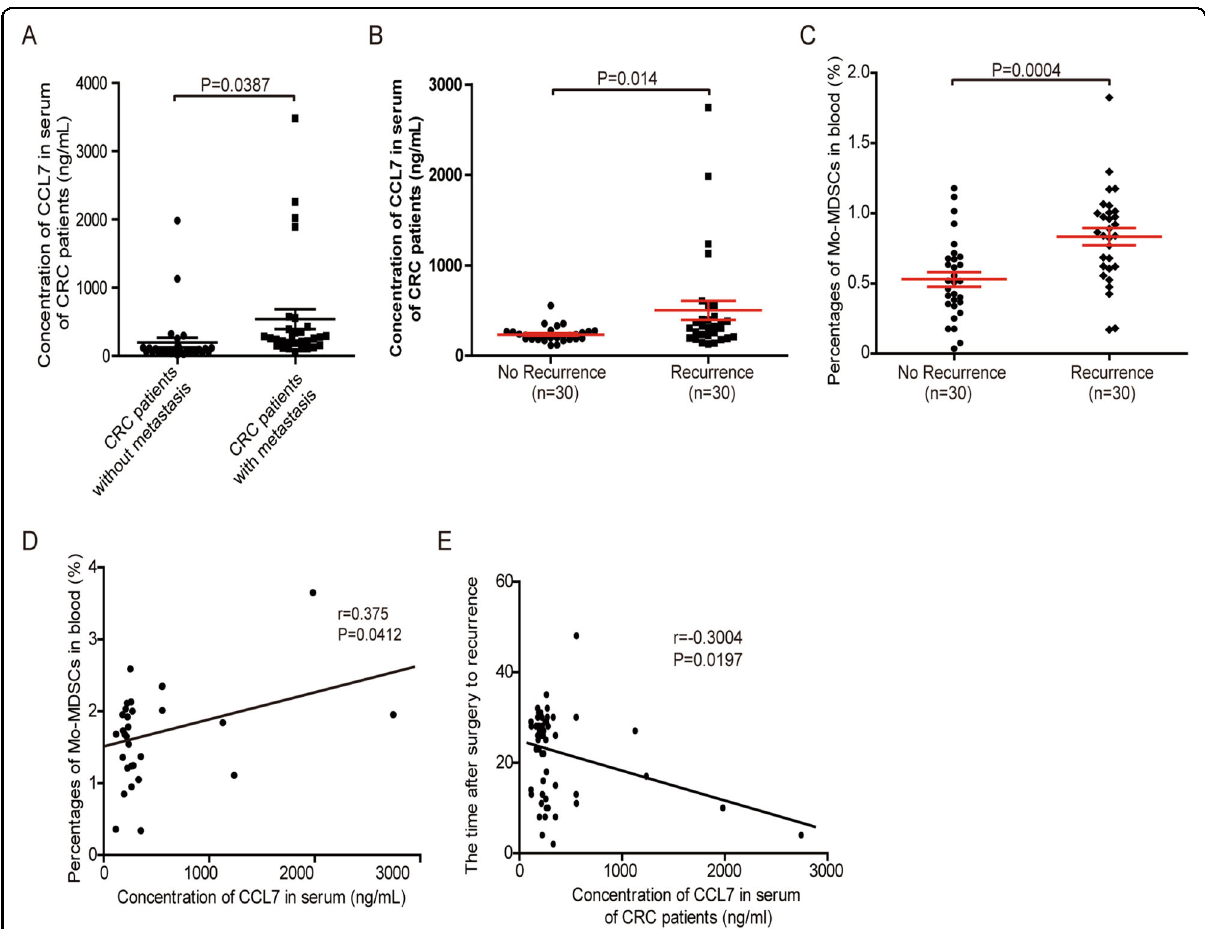
Fig. 7 The level of CCL7 in serum of CRC patients is highly linked with the short-time recurrence and distant metastasis. A The level of CCL7 in the serum of CRC patients with or without metastasis detected by Elisa assays ( n = 60). B The level of CCL7 in the serum of CRC patients with or without short-time recurrence (<2 years) detected by Elisa assays ( n = 30). C The percentages of MDSCs in the blood of CRC patients with or without short-time recurrence (<2 years) detected by Flow cytometry ( n = 30). D Relationship of the level of CCL7 in the serum with the percentages of MDSCs in the blood of CRC patients ( n = 30). E Relationship of the level of CCL7 in the serum with the time after surgery to recurrence ( n =